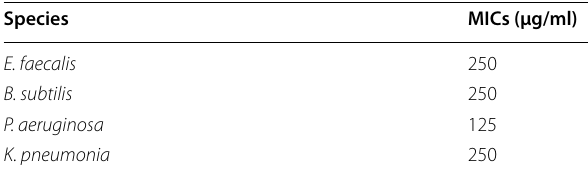
Table 4 Minimum inhibitory concentration of M. minuta leaves extract Species MICs